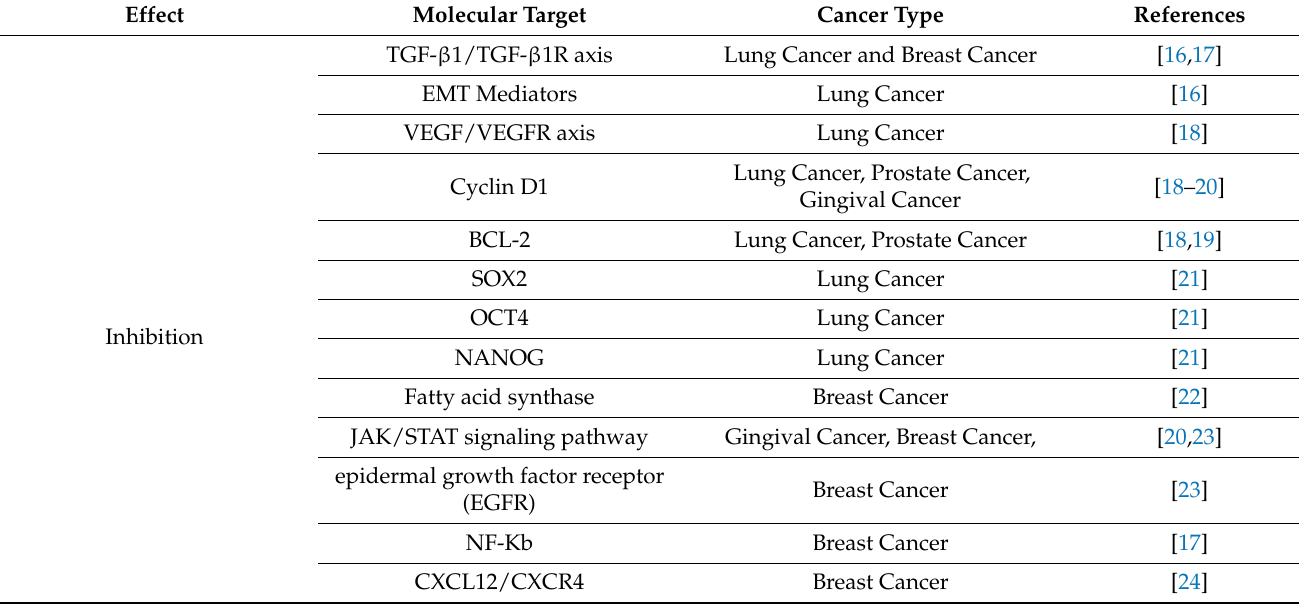
Table 1. Molecular targets of tannic acid (TA) in various neoplastic diseases.